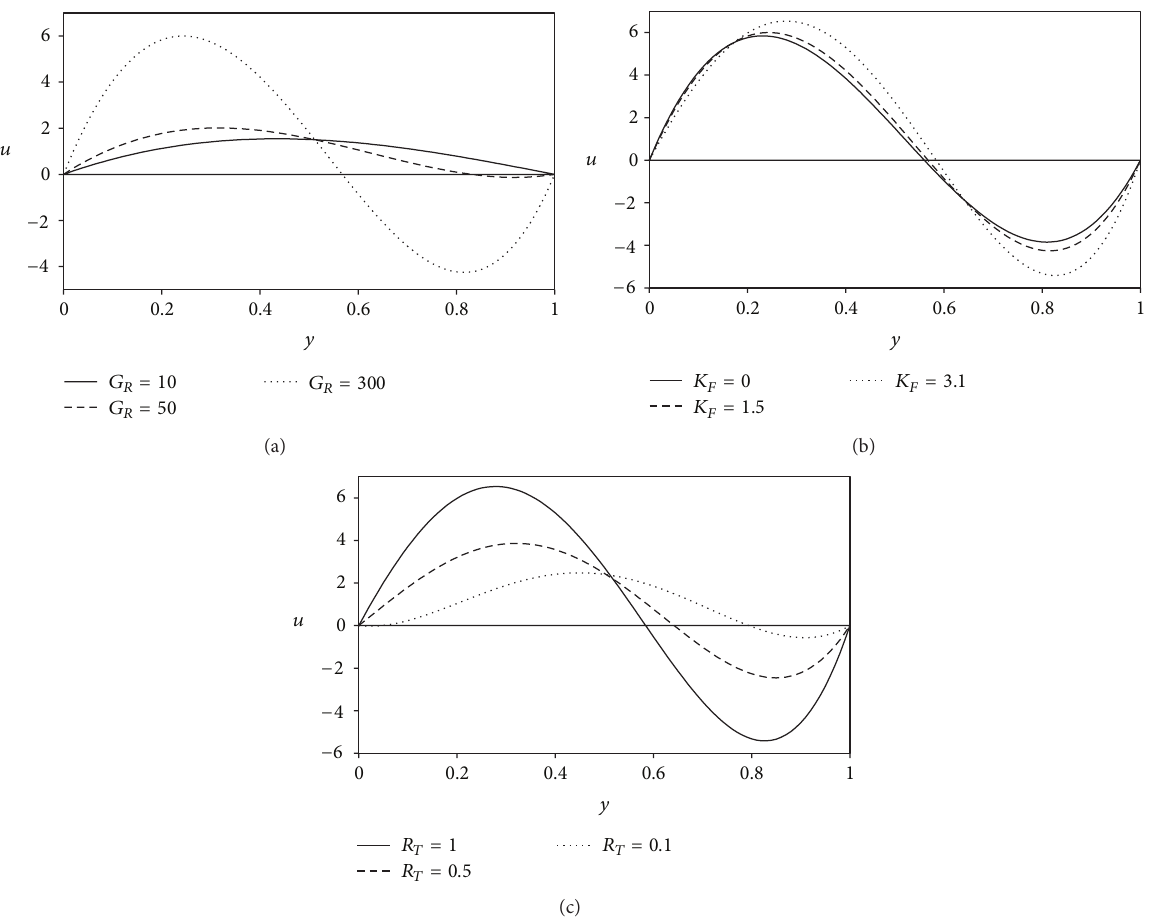
Figure 2: Plots of 𝑈 versus 𝑌 for different values of (a) 𝐺 𝑅 where 𝐾 𝐹 = 1.5, 𝑅 𝑇 = 1 (b) 𝐾 𝐹 where 𝐺 𝑅 = 300, 𝑅 𝑇 = 1 , and (c) 𝑅 𝑇 where = 300, 𝐾 = 3.1 . 𝐺 𝑅 𝐹